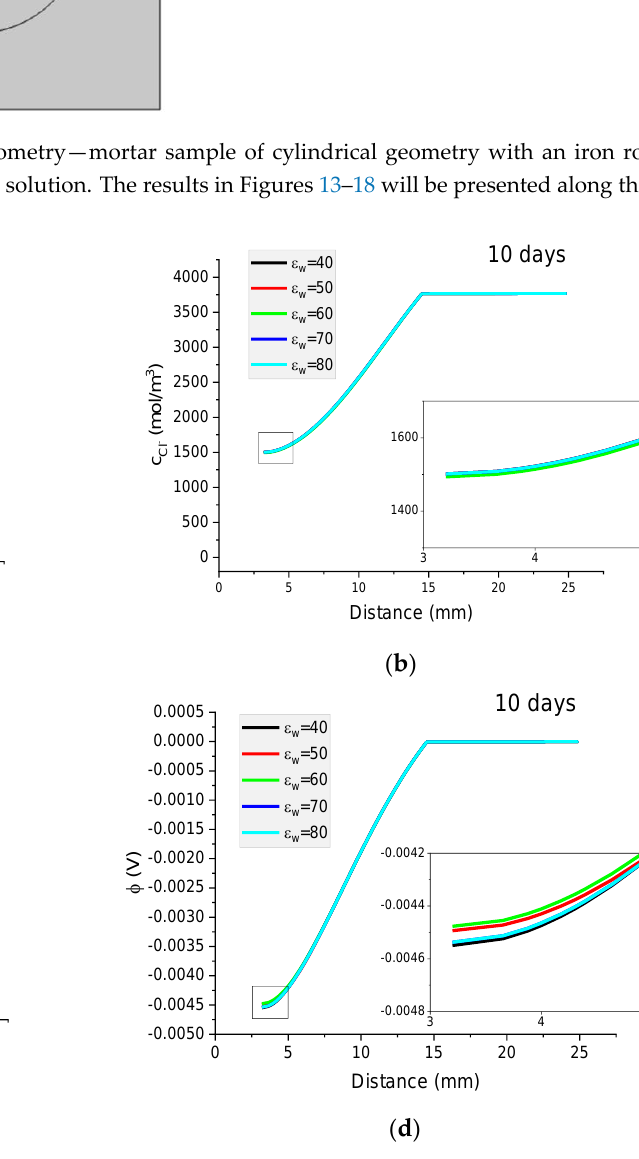
Figure 13. The influence of relative permeability on calculated concentration profiles of chloride ions in the mortar immersed in 20 wt% NaCl water solution after ( a ) 1 day; ( b ) 10 days; and potential distribution after ( c ) 1 day and ( d ) 10 days.